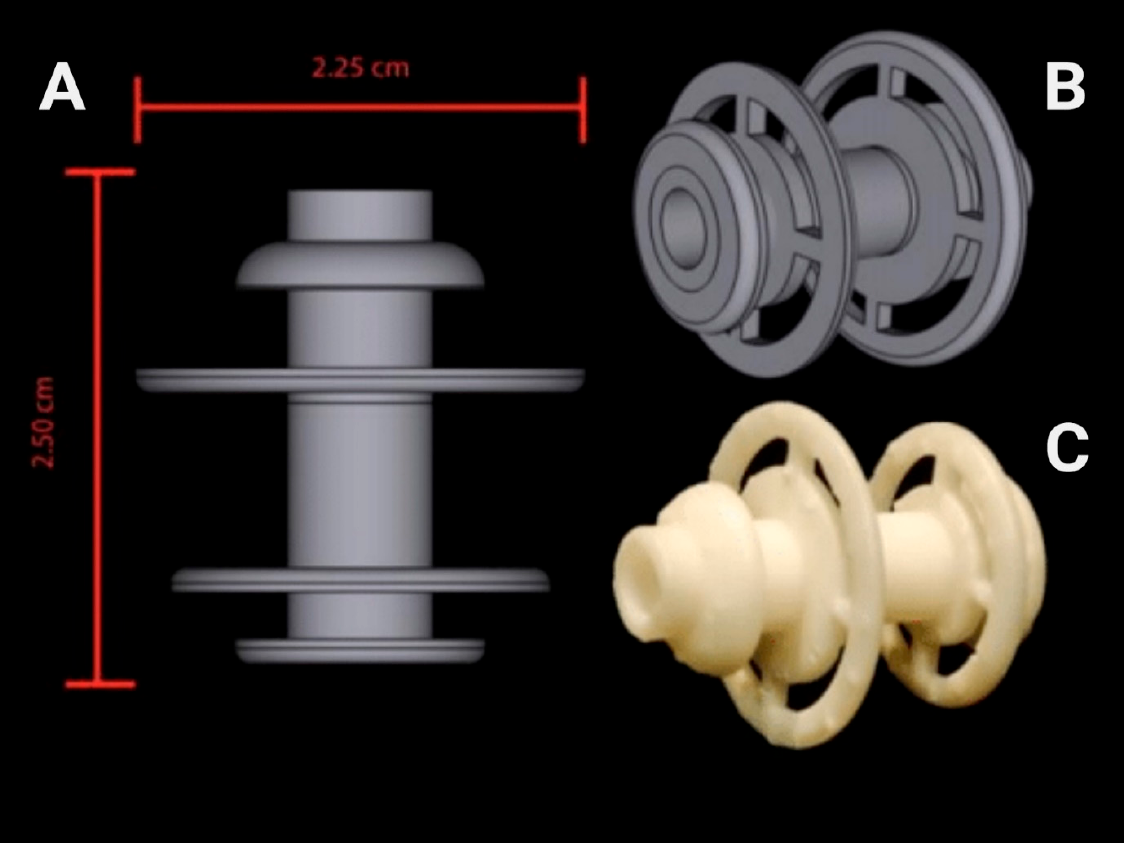
Figure 1. Fistula Design. Fistulas were designed in Shapr3D Software (A; lateral view; B; oblique view). Formlabs High Temp Resin-printed fistula (C).